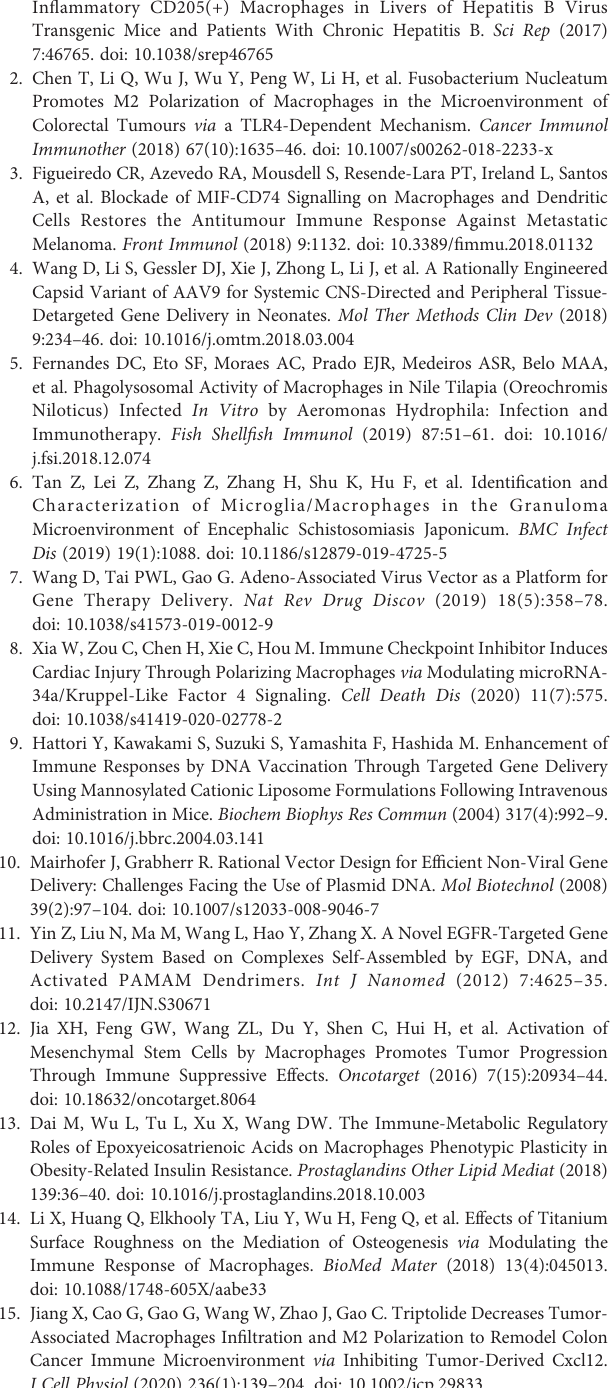
inhibited iNOS expression in LPS induced in fl ammatory MDM. Error bars represent the standard error of the mean (s.e.m.). * p < 0.01 by comparison to LPS group. Supplementary Figure 5 | IL4/GFP expression in IL-4pDNA-rNPs treated